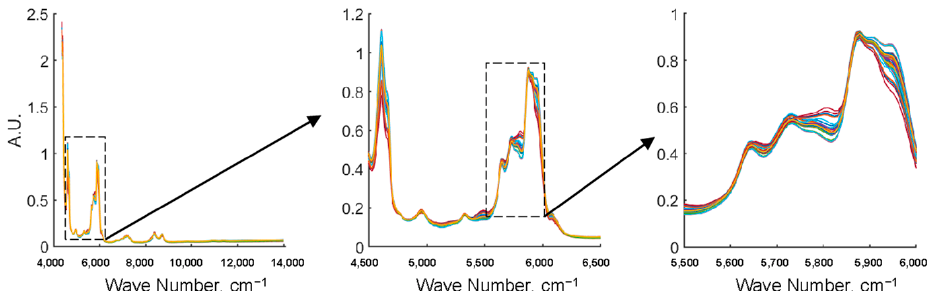
Figure 2. Original NIR spectra of all the samples in the library.